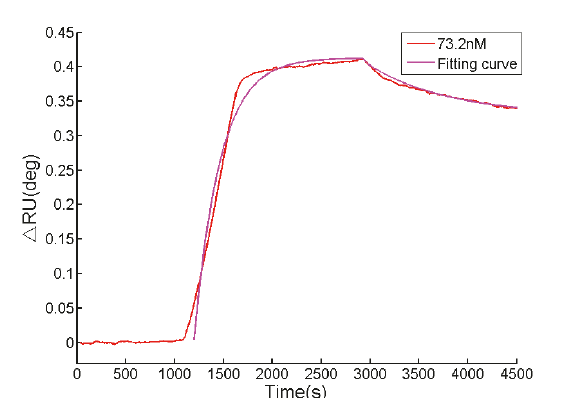
Figure 7: Interaction curve for 73.2nM